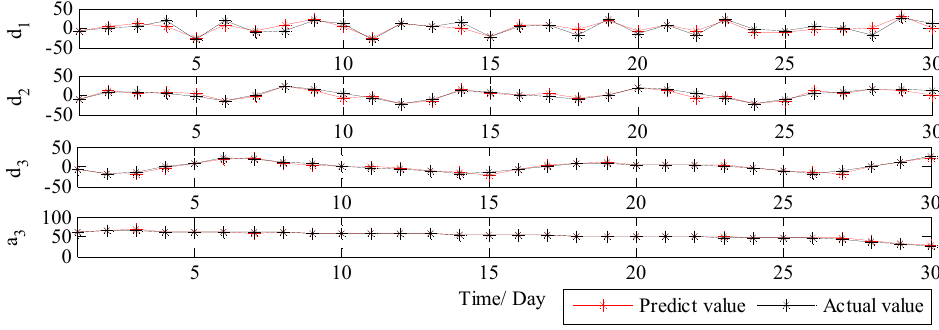
Figure 15. The forecast results of each subset by WT-DE-BP model (Tianjin). Int. J. Environ. Res. Public Health 2017 , 14 , 764 19 of 23